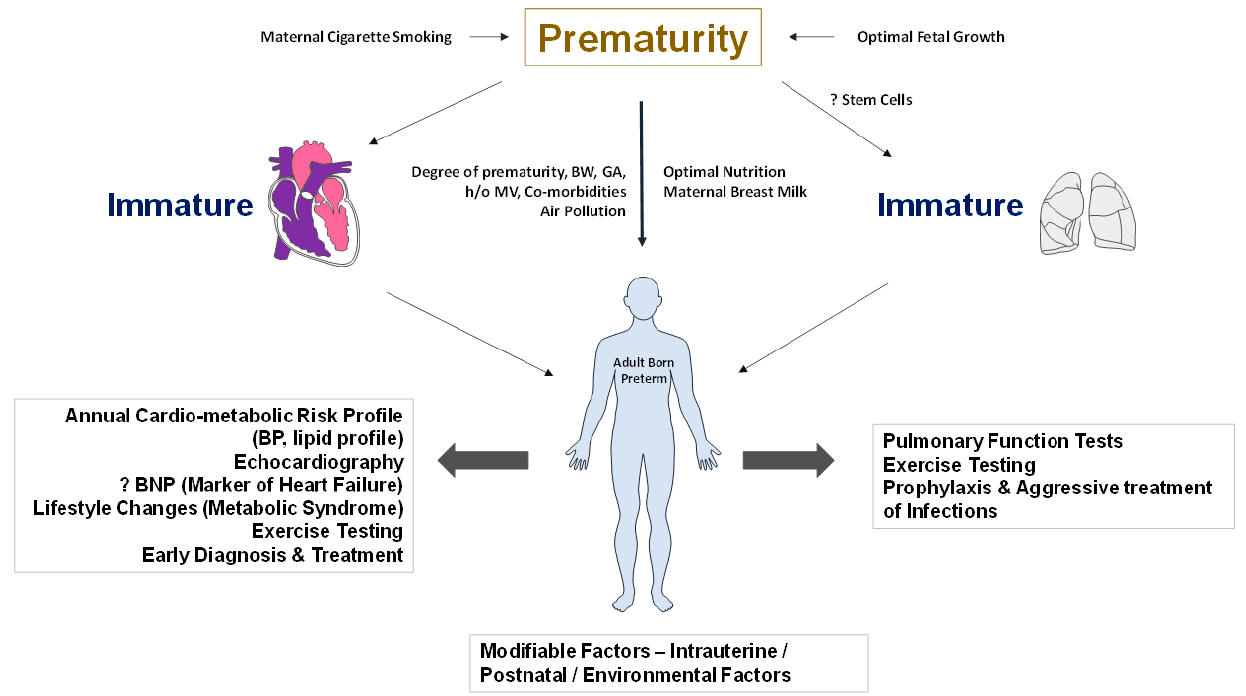
Figure 3. Screening, early diagnosis, and interventions that would improve the quality of life in adults born preterm. Maternal cigarette smoking and intrauterine growth retardation contribute adversely to fetal development. Optimal postnatal nutrition and maternal breast milk promotion may facilitate organ system growth patterns. Screening for metabolic syndrome, biomarkers for de- tection of heart failure, and pulmonary function tests for obstructive airway disease may help in the early diagnosis and management of comorbidities. Lifestyle changes to promote wellness are of particular importance in adults born preterm. The role of stem cells in promoting lung growth